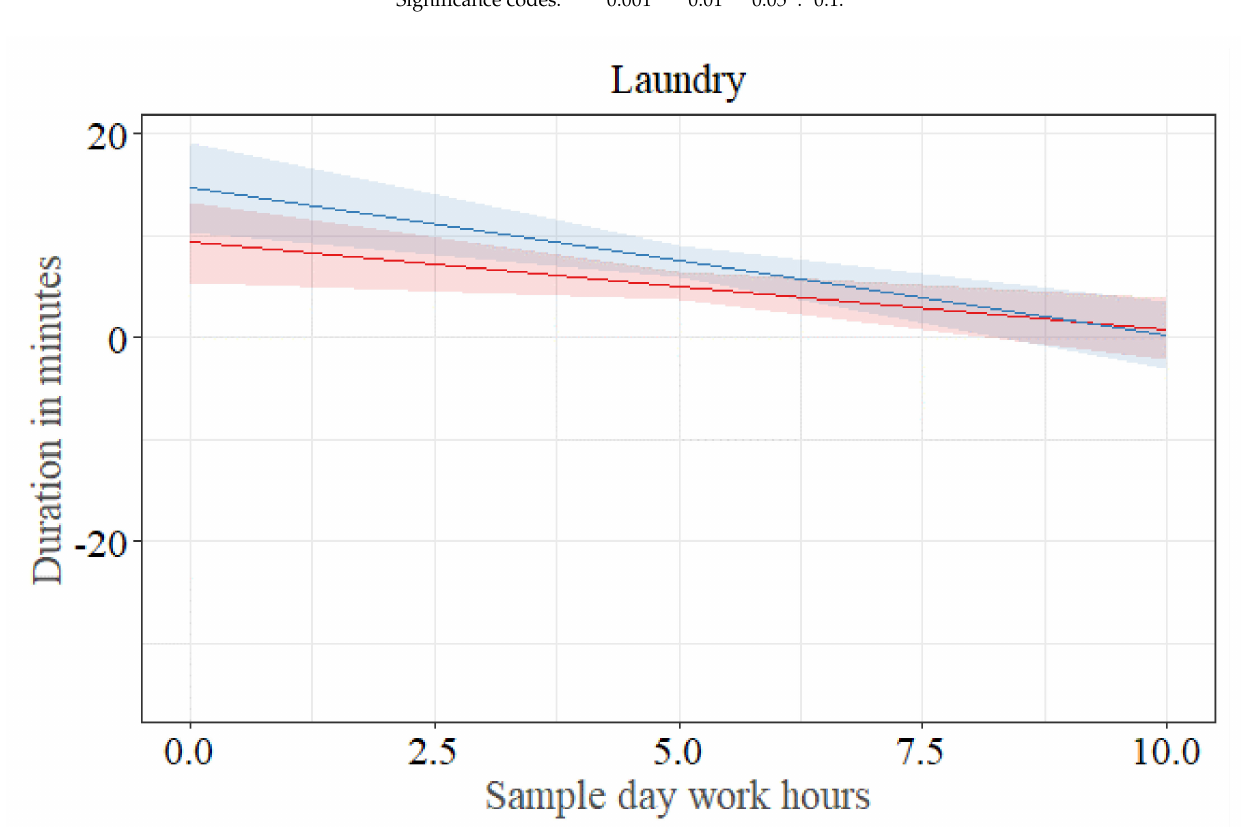
Figure 5. Significant linear regression lines of regular work patterns (blue line part-time and red line